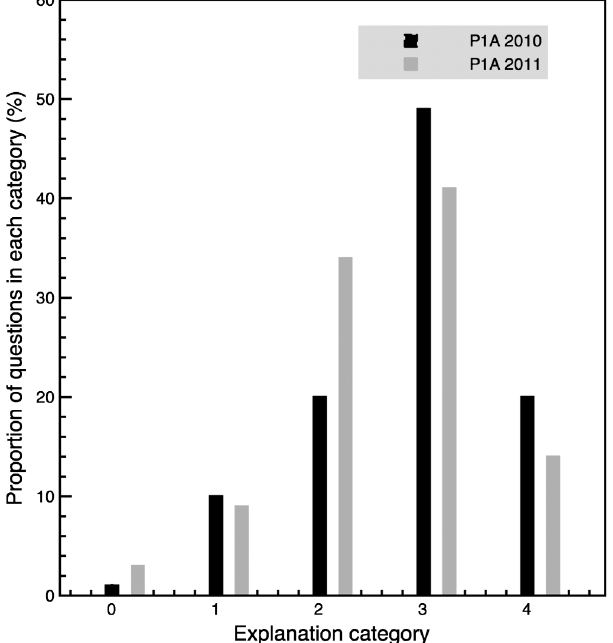
FIG. 4. Proportion of questions in each explanation category, for Physics 1B question repositories for 2010 ( N ¼ 179 , dark bars) and 2011 ( N ¼ 73 , light